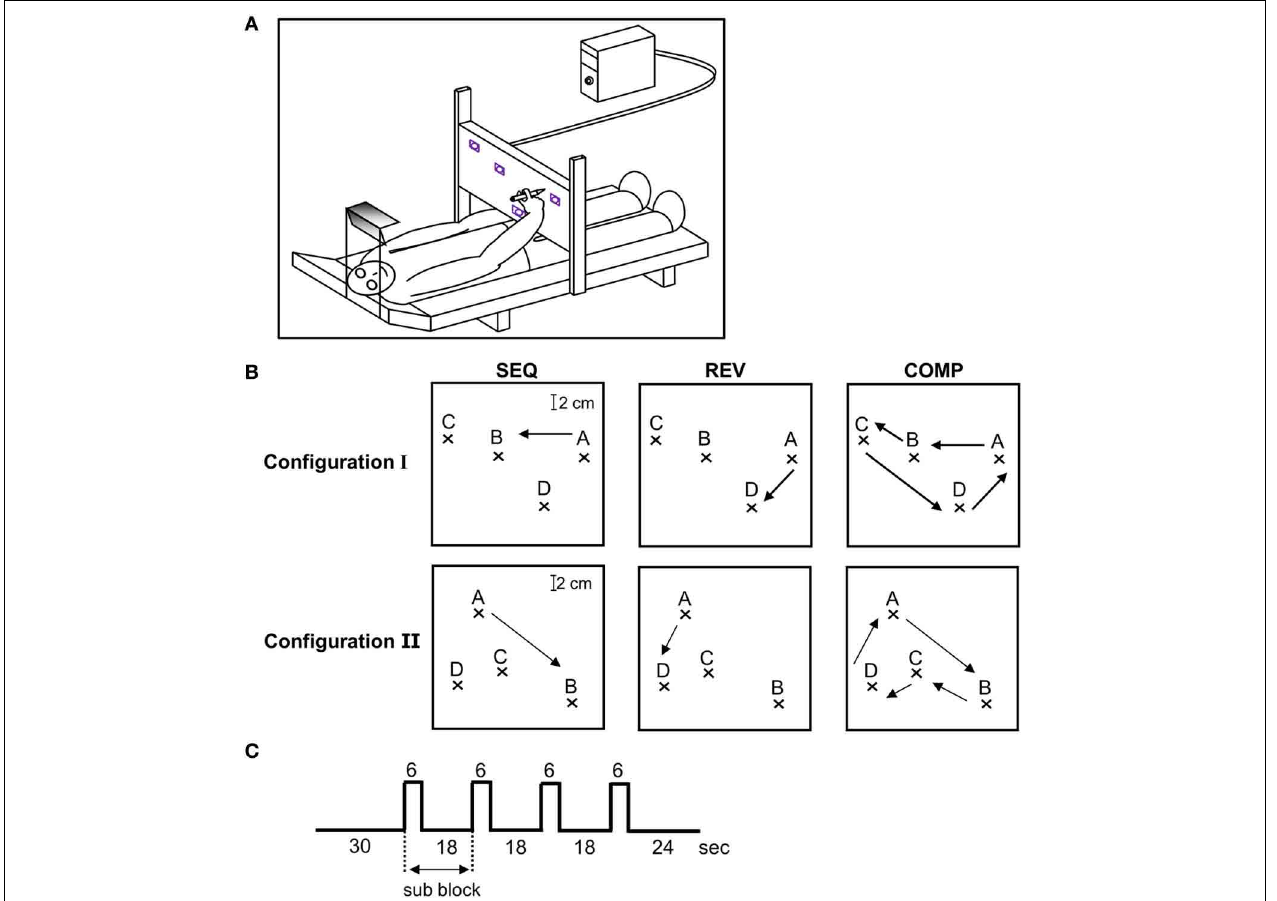
FIGURE 1 | Experimental design. (A) Experimental set-up. The recording system outside the fMRI scanner was composed of a bed surrounded by an adjustable metal scaffold. A digitizing tablet was mounted on the scaffold above the subject’s hip level in the horizontal plane crossing the hip at a convenient distance to reach the tablet with a pen. To minimize shoulder movements, prevent any head movements and guarantee an fMRI-like head position, subjects looked through a double mirror system at the workspace of the tablet. The field of view, head position, and